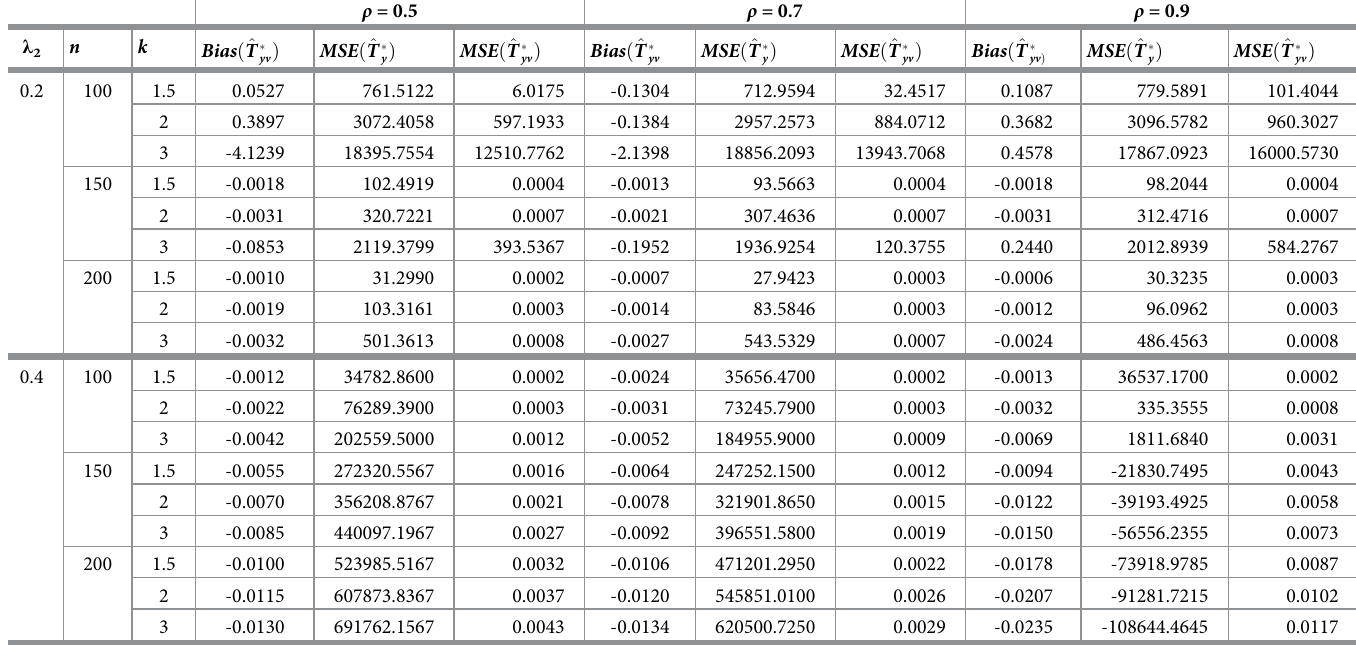
Table 3. Bias and MSEs with σ 2 = 0.1 and p =